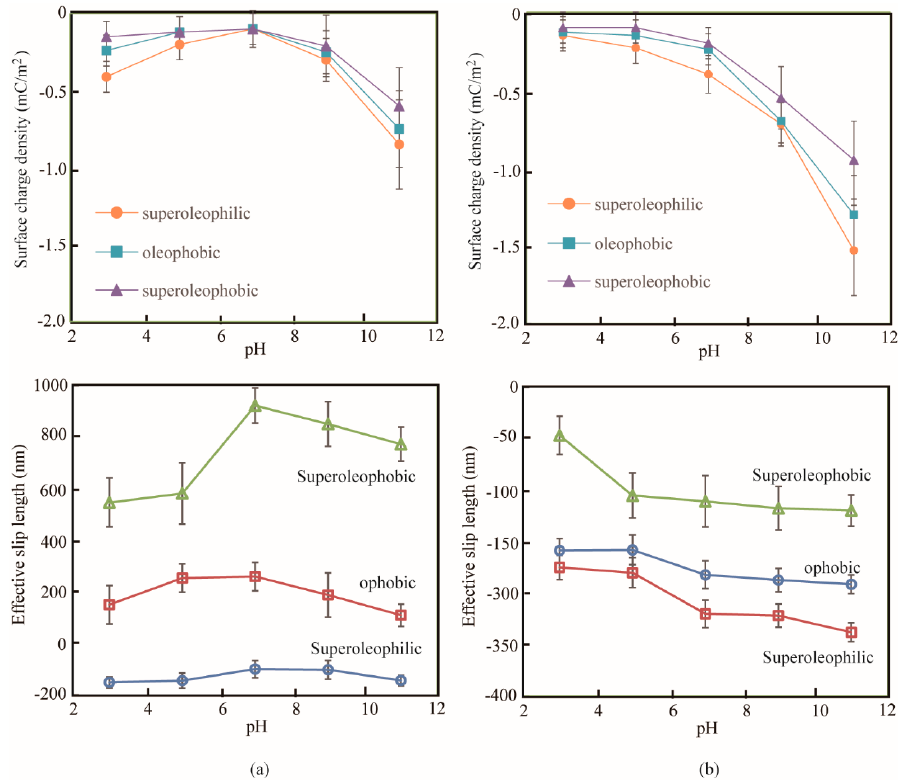
Figure 8. The effect of the surface charge density on the effective boundary slip length of rough samples immersed in ( a ) ethylene glycol and ( b ) DI water with different pH